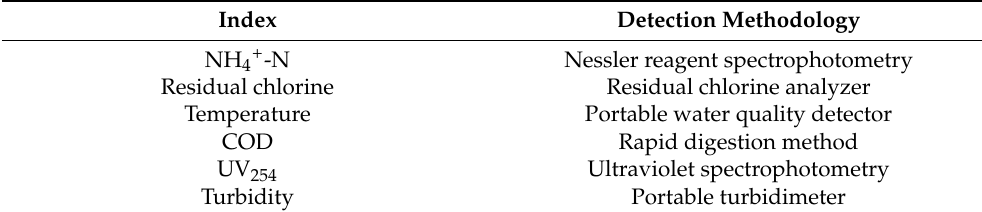
Table 3. Methods for the detection of conventional water quality